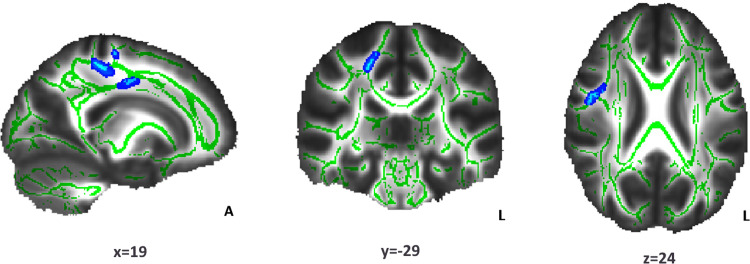
Relationship between Fractional Anisotropy (FA) and loss accuracy in the overweight group.The light blue color indicates the white matter clusters that showed a relationship (non-significant) between FA and loss accuracy (at the indicated coordinates) (α = 0.10, threshold-free cluster enhancement and family-wise error correction). The mean skeleton of FA is shown in green. Right white matter tracts include the corticospinal tract, superior corona radiate, and superior longitudinal fasciculus. Coordinates are presented in Montreal Neurological Institute (MNI) template space. A: anterior; L: left.